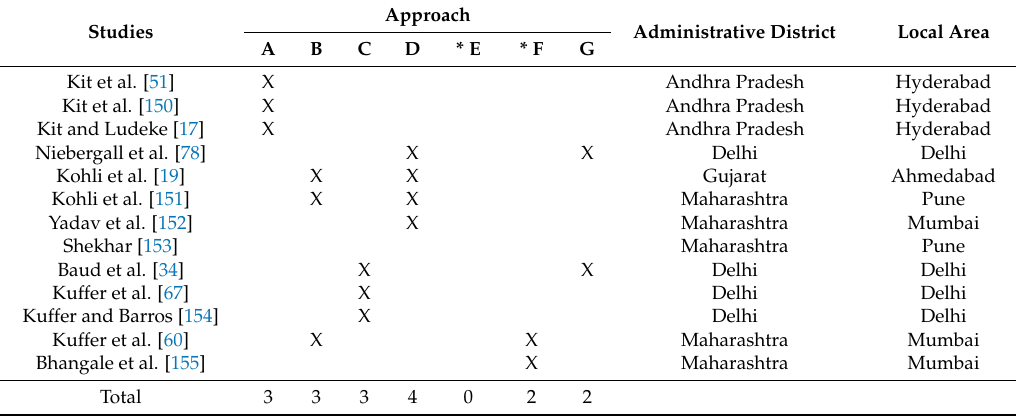
Table 2. Studies of slums in India using H/VH-R imagery, classified by analysis approach. (A) Multi-scale analysis; (B) Image texture analysis; (C) Landscape analysis; (D) Object-based image analysis; (E) Building feature extraction; (F) Data mining and (G) Remote sensing data for supporting socio-economic assessment.